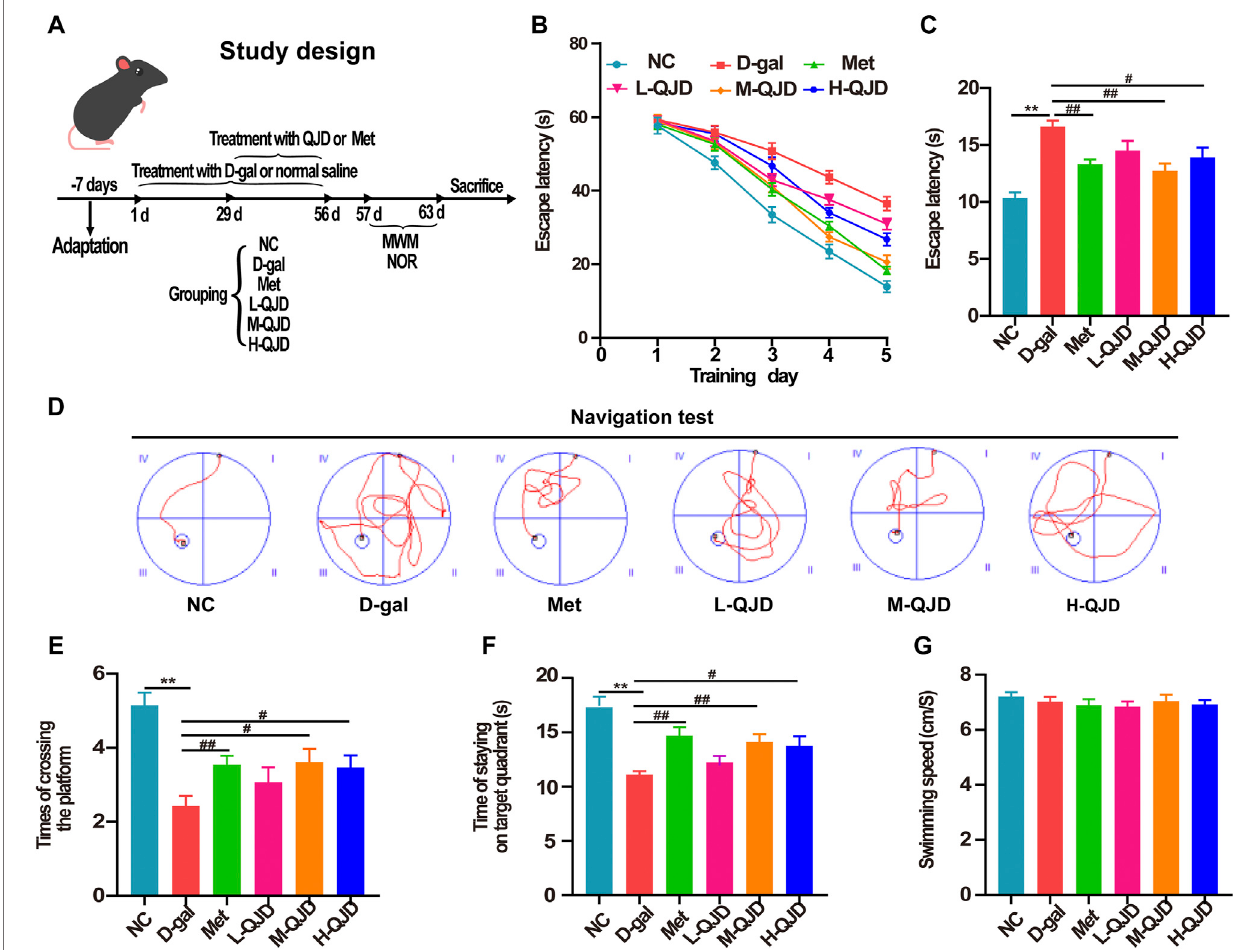
FIGURE 1 | QJD alleviated learning and memory impairments in D-gal – induced mice. (A) Study design. (B) Mean escape latency to the platform of each group during the training session of fi ve consecutive days. (C) Escape latency to the platform of each group in the navigation test. (D) Representative path tracings of each group in the navigation test. (E) The number of crossing platform in the permitted 60 s. (F) Time of staying on the target quadrant in the permitted 60 s. (G) The mean swimming speed of mice in all groups. All data were presented as mean ± SEM ( n (cid:1) 10/group). ** p < 0.01 vs. NC group; # p < 0.05 and ## p < 0.01 vs. D-gal group.